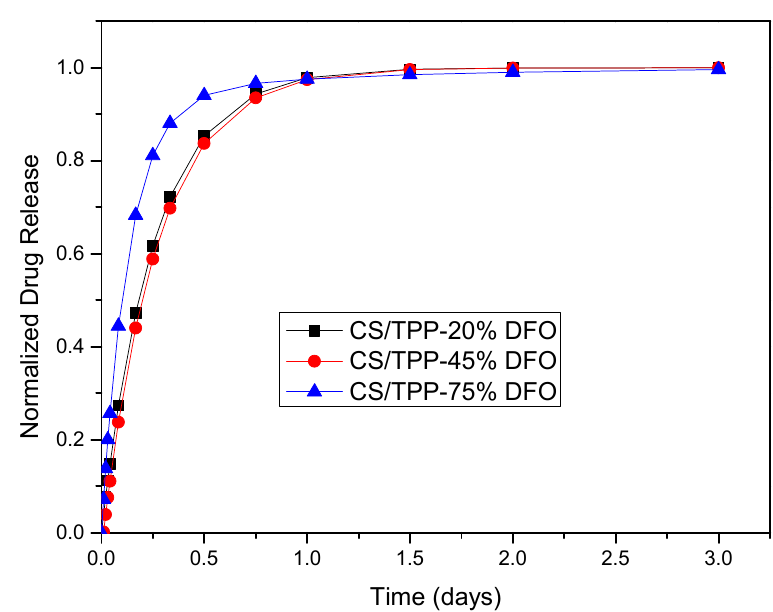
Figure 10. Comparison between experimental (symbols) and model (lines) normalized drug release results for three types of nanoparticles.